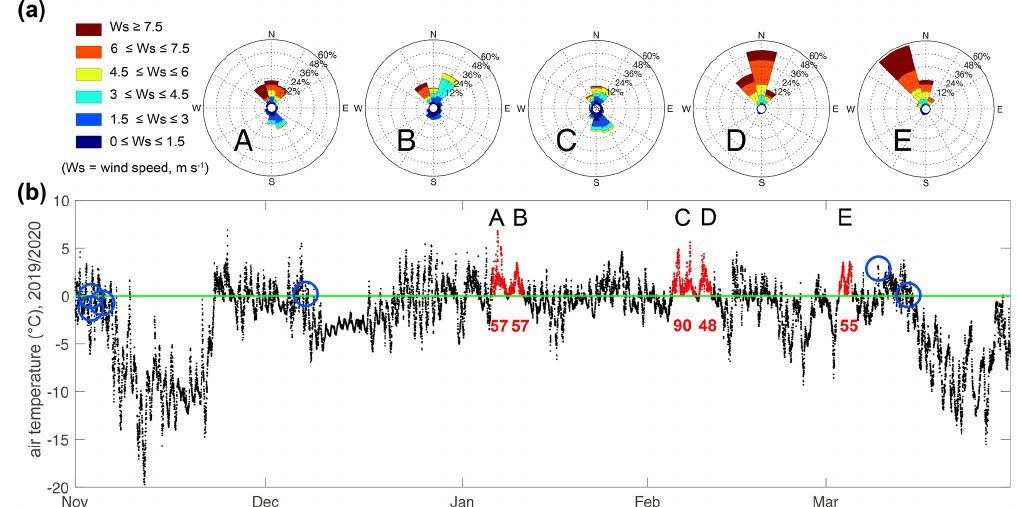
Figure 7. The 2019/2020 wind and air temperature and data (10min) from the Fossil Bluff AWS. (a) Wind roses for corresponding periods of sustained air temperatures (A–E) indicated in (b) . (b) Air temperature record for 2019/2020 with the five longest periods of temperatures ≥ 0 ◦ C shown in red. The red numbers below these time periods indicate the total number of hours when the temperature is continuously ≥ 0 ◦ C. It is notable that only 9h separates periods A and B and only 14h separates C and D. The six blue circles indicate periods when we calculate foehn conditions to be present (see Sect. 3.4 for